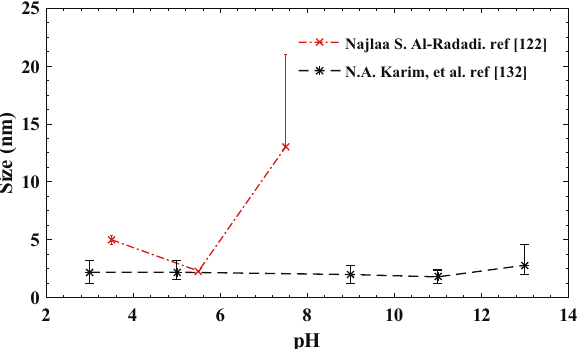
Figure 1: The e ff ect of pH on the size variation, adapted from refs. [ 122 and 132 ]